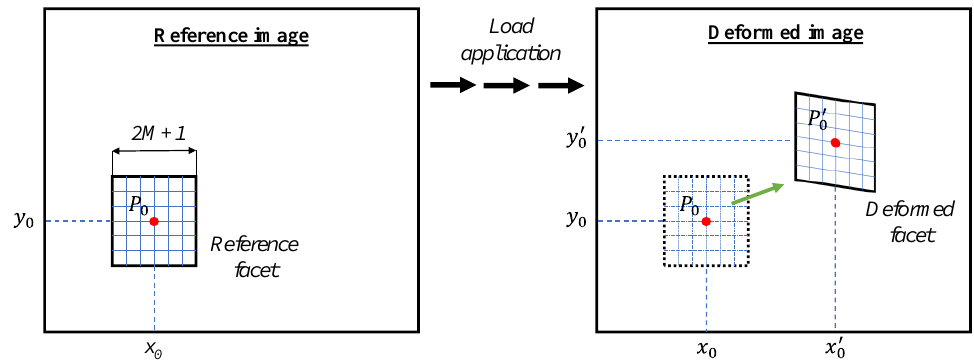
Figure 4. Final configuration of concrete beams with externally bonded PBO-FRCM sheet: front view ( top ) and bottom view ( bottom ). All sizes are reported in mm.